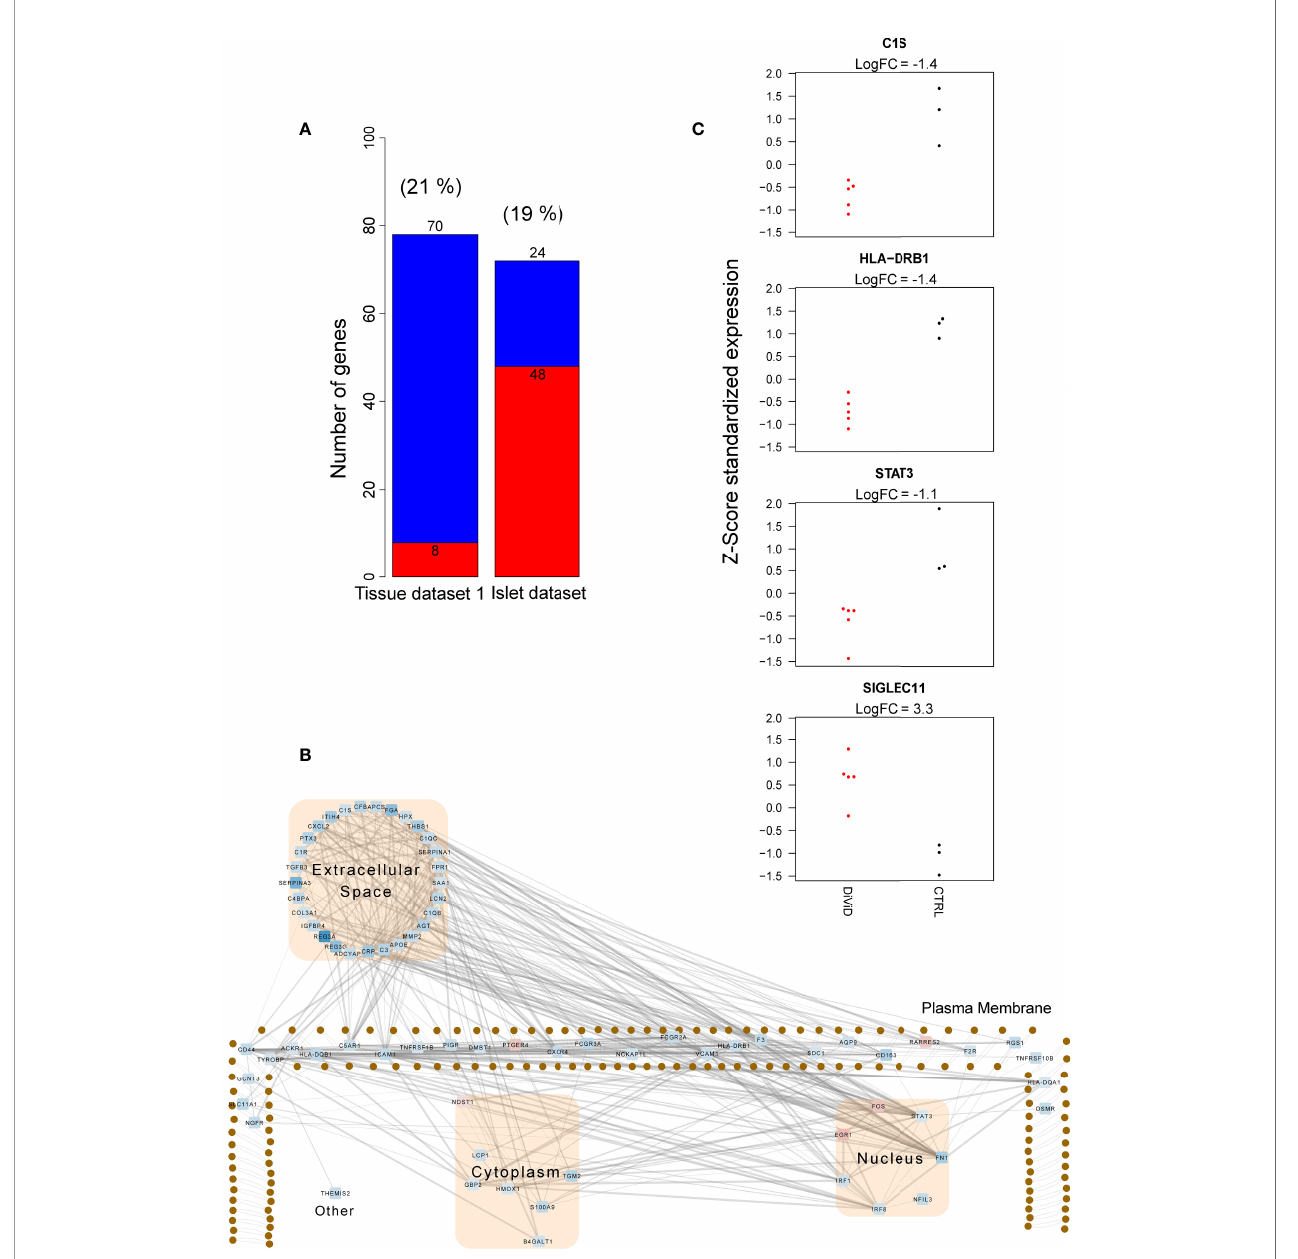
FIGURE 3 | Immune and in fl ammatory responses in the whole pancreas transcriptome 1 and the pancreatic islet transcriptome. (A) The number of up-regulated (red) and down-regulated (blue) immune and in fl ammatory response genes between the DiViD patients and the controls. The differentially expressed (DE) genes were identi fi ed using the reproducibility optimized test statistic (ROTS) (30) with a false discovery rate of ≤ 0.05 and |FC| ≥ 2. Genes in the biological processes GO:0006955 (immune response) and GO:0006954 (in fl ammatory response) were examined. The proportion of DE genes in each dataset mapping to the examined gene ontology (GO) terms is shown in brackets. The difference in the number of both up- and down-regulated genes of all the included immune and in fl ammatory response genes between the whole tissue transcriptome 1 and the islet transcriptome was highly statistically signi fi cant (P<0.0001, two proportions z-test). (B) The subcellular protein-protein interaction network of the products of the differentially expressed genes in the biological processes GO:0006955 (immune response) and GO:0006954 (in fl ammatory response) in the whole tissue transcriptome 1. The protein-protein interactions were queried from the STRING functional protein association database (33). Only high con fi dence interactions (con fi dence score ≥ 0.7) were regarded. Ingenuity Pathway Analysis (IPA) (QIAGEN Inc.) (36) was applied for the determination of subcellular locations and Cytoscape (37) for the visualization of the network. The color of the nodes in the network represent the expression of the genes: red represents up-regulation, while blue represents down-regulation. (C) Z-score standardized expression of the selected differentially expressed in fl ammatory genes in the whole tissue transcriptome 1. Red color = samples from the DiViD patients, black color = samples from non-diabetic organ